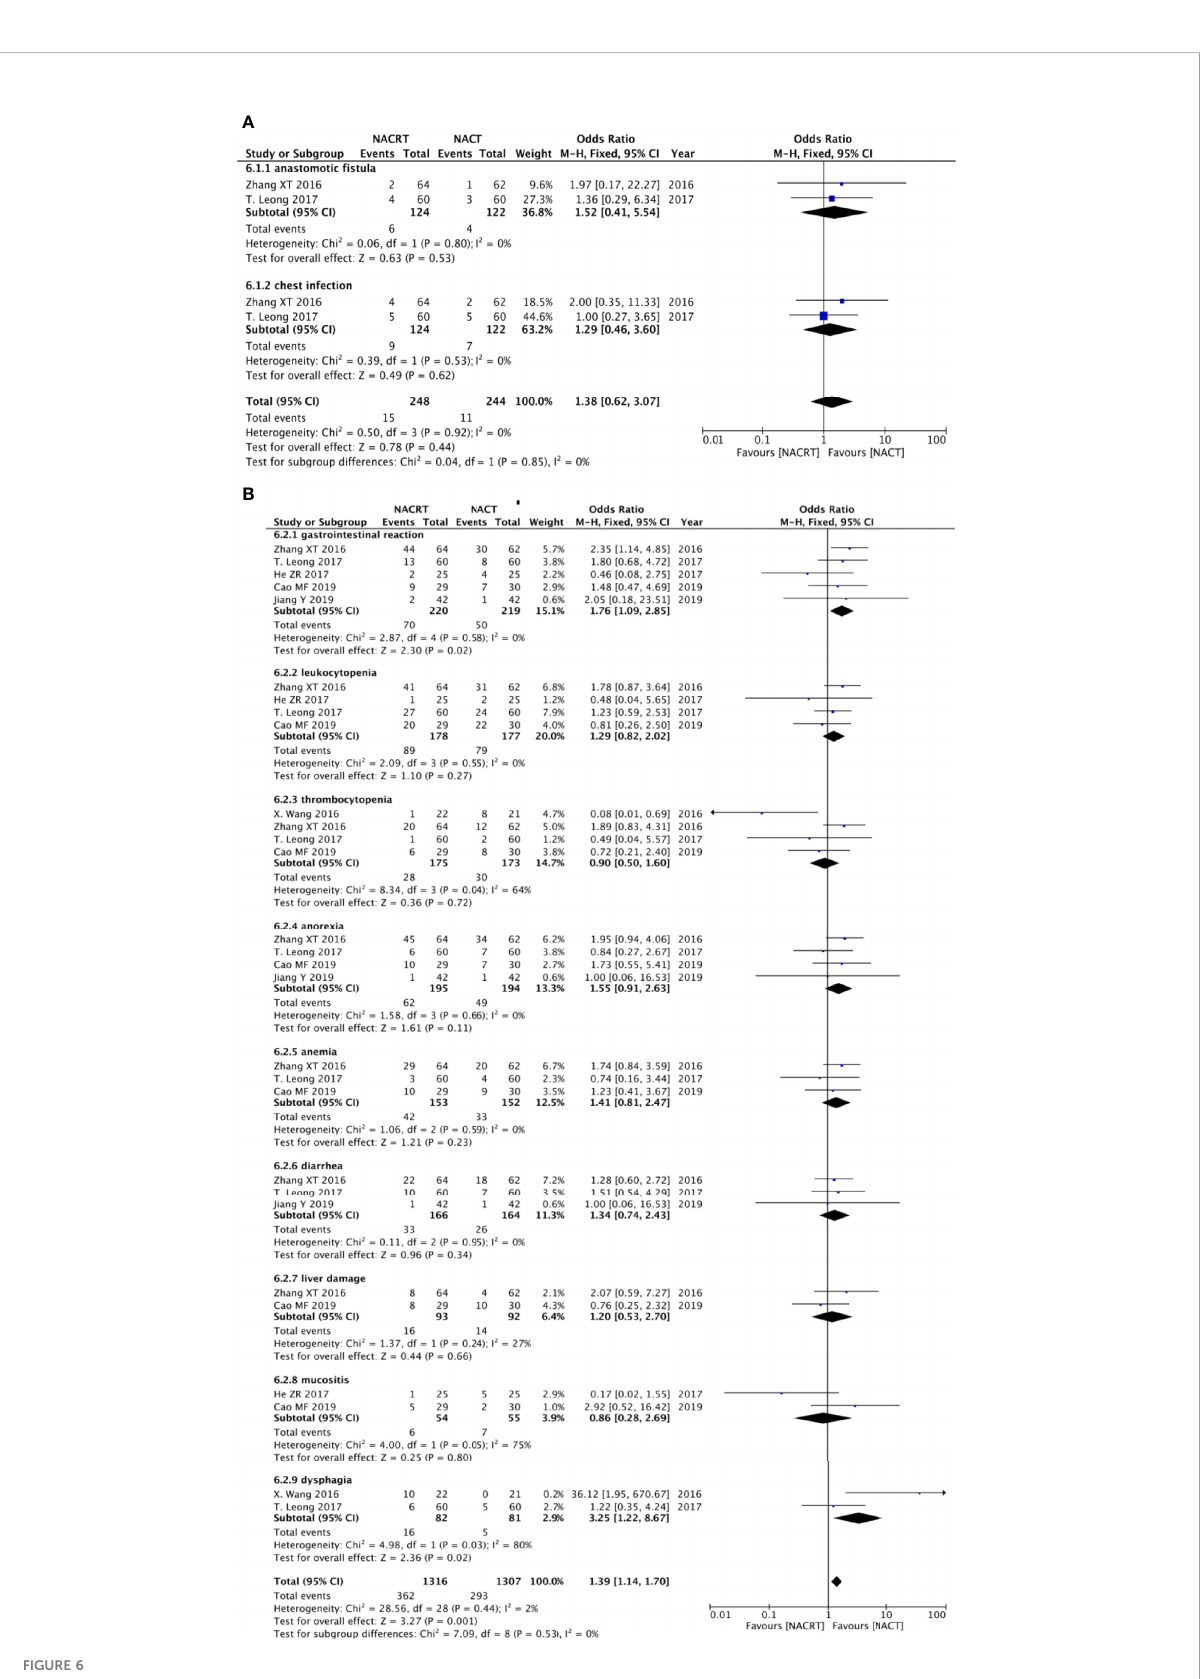
FIGURE 6 Forest plot for postoperative complications (A) and adverse effects after neoadjuvant therapy (B)